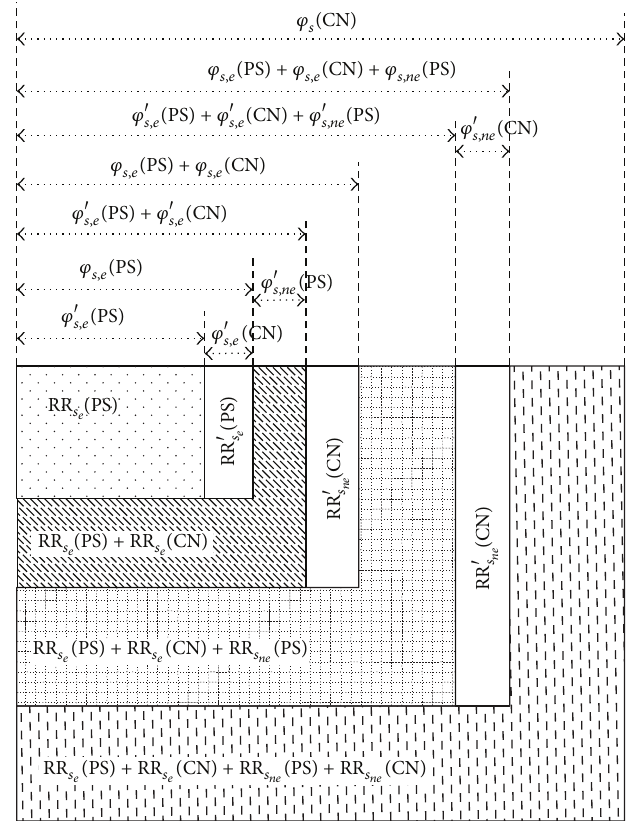
Figure 3: Frequency situation usage based